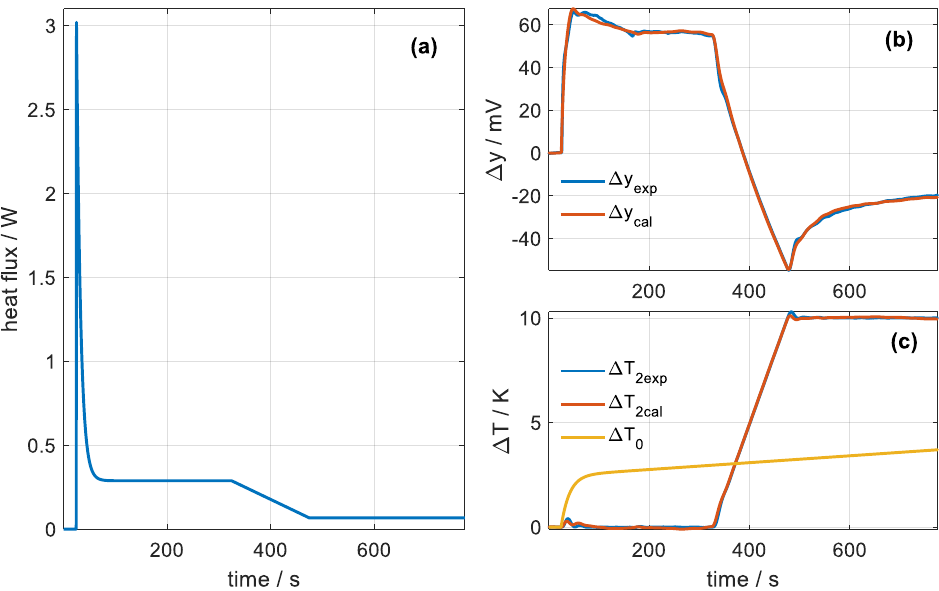
Figure 12. ( a ) Heat flow obtained from measurement M1 in Figure 10. ( b ) Adjustment of the calorimetric signal ∆ y . ( c ) Thermostat temperature fitting ∆ T 2 and representation of ∆ T 0 .